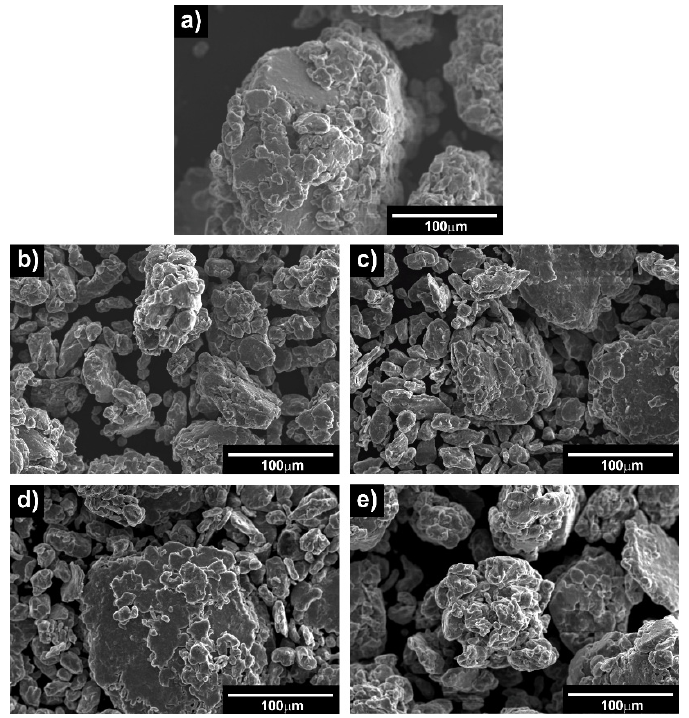
Figure 1. Micrograph of the powders after the grinding stage for the studied compositions: ( a ) 100 vol.% Al, ( b ) Al/0.5 vol.% WC, ( c ) Al/1.0 vol.% WC, ( d ) Al/0.5 vol.% mullite and ( e ) Al/1 vol.% mullite.